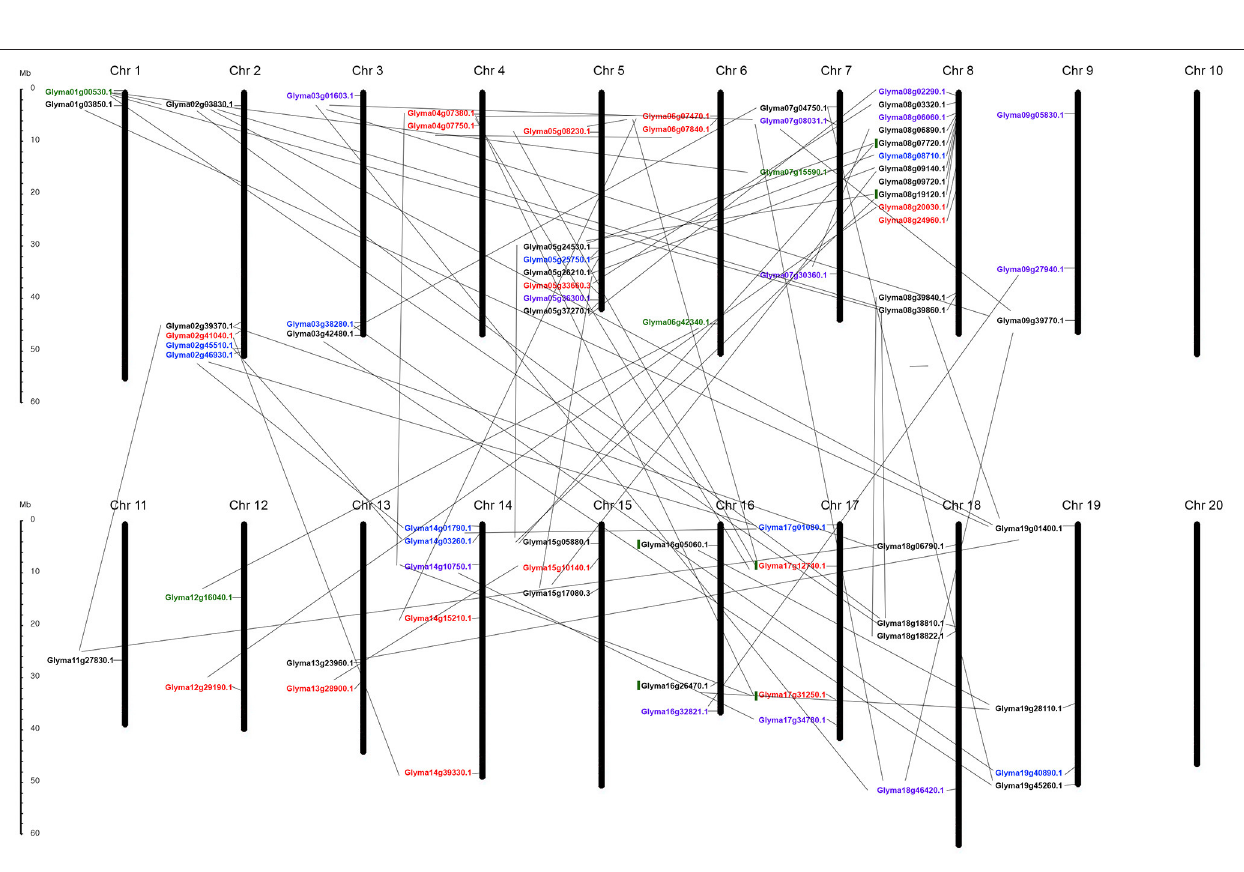
FIGURE 5 | Chromosomal distribution of all 70-putative K + transporter genes and their duplication within genome. All chromosomes have K + transporter related genes except Chr 10 and Chr 20. Black, red, blue, green, purple indicate genes belonging to HAK/KT/KUP, voltage-gated K + channel, TPK/KCO, HKT, and KEA families respectively. Gray lines represent gene duplications in each